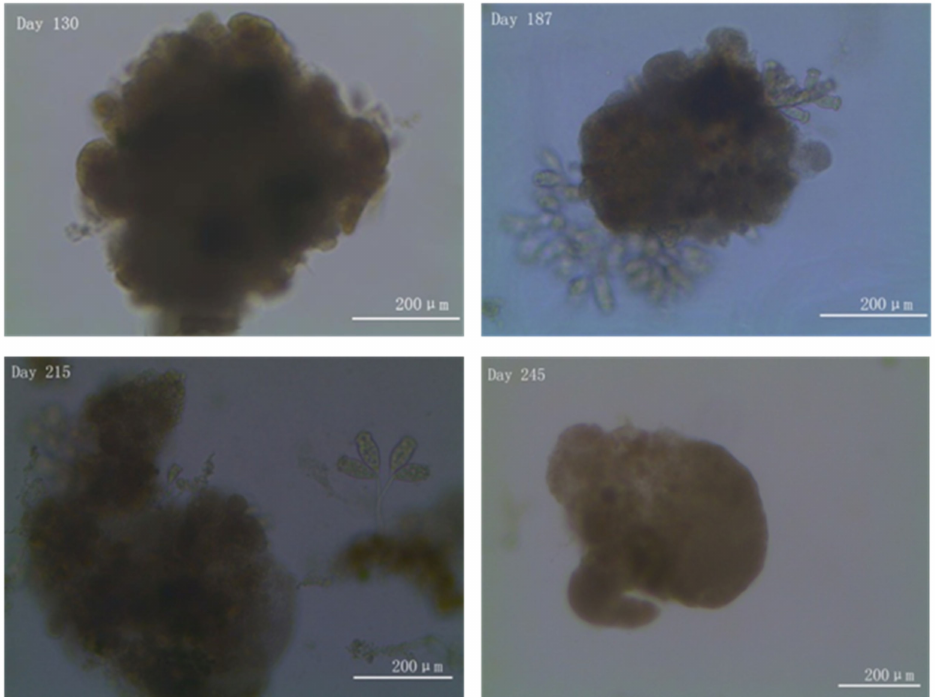
Figure 7. Morphologies of the aerobic granules on different operation